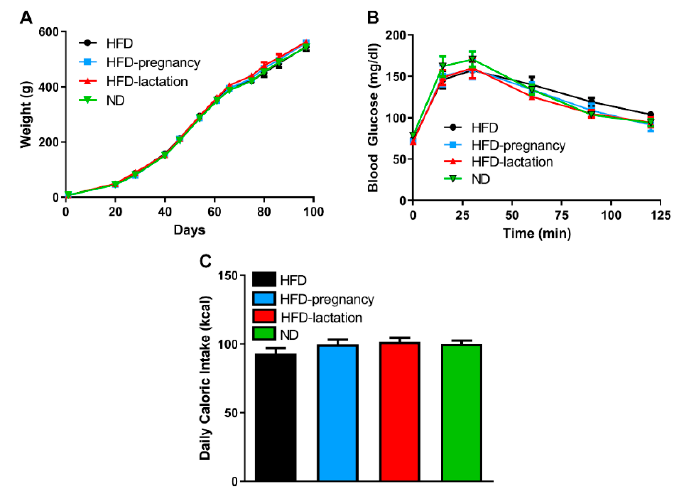
Figure 3. Offspring characteristics. Offspring body weight ( A ), glucose tolerance ( B ), average daily caloric intake ( C ). Group representations are the followings: black symbols and lines ( A , B ) or columns ( C ): HFD offspring ( n = 9), black symbols and lines ( A , B ) or columns ( C ); HFD-pregnancy offspring ( n = 9), light blue symbols and lines ( A , B ) or columns ( C ); HFD-lactation offspring ( n = 7), red symbols and lines ( A , B ) or columns ( C ); ND group of offspring ( n = 9), green symbols and lines ( A , B ) or columns ( C ). Data expressed as mean ± SEM. For more details and statistics, see Results.